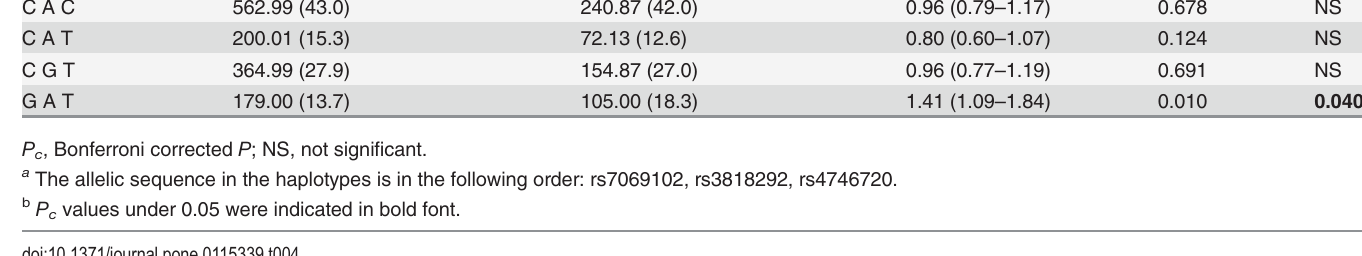
Table 4. Association between haplotypes of the three tagSNPs in SIRT1 gene with the risk of MI. Haplotype a Controls (n = 654) No. (%)